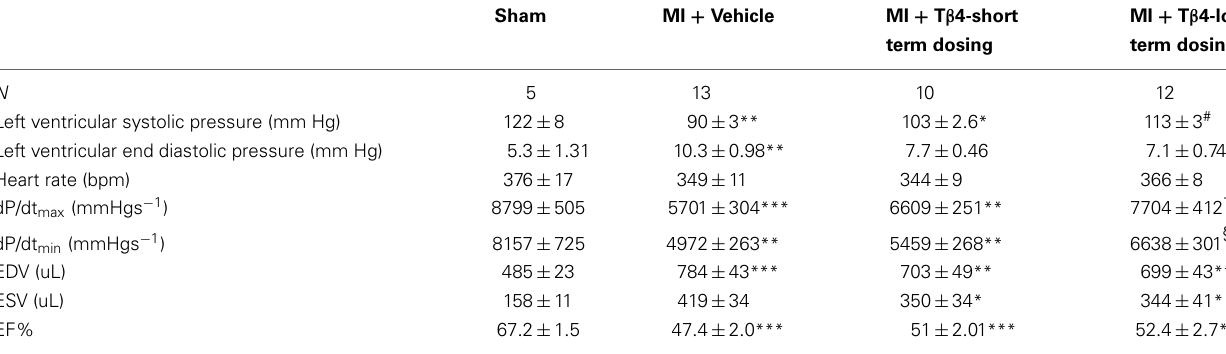
Table 1 | Cardiac function 4 weeks after myocardial infarction.